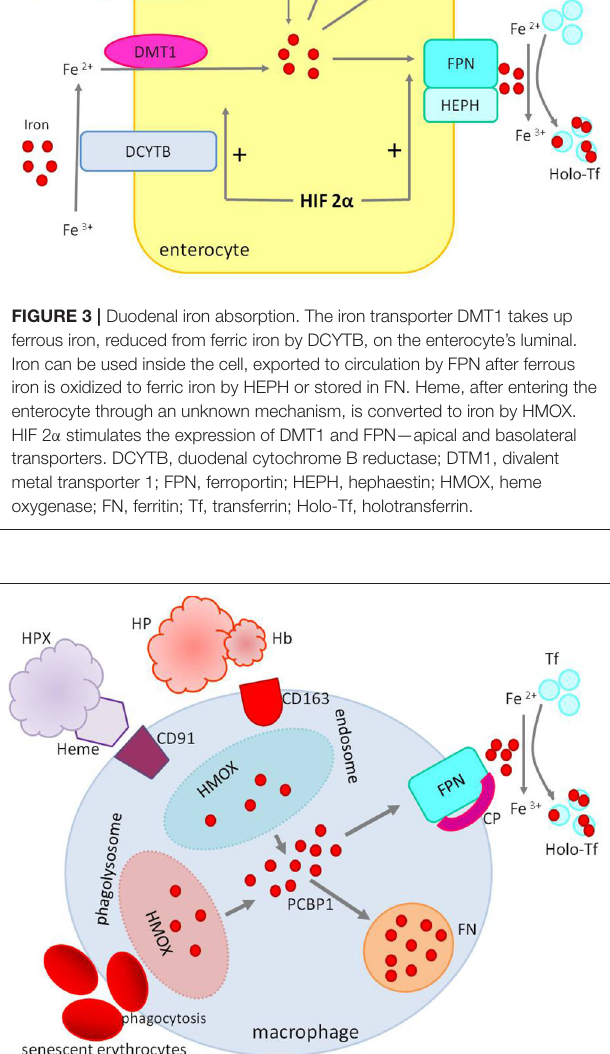
for this connection are the interactions between STAT3 and SMADs at the level of hepcidin promoter and activin B (23) ( Figure 5